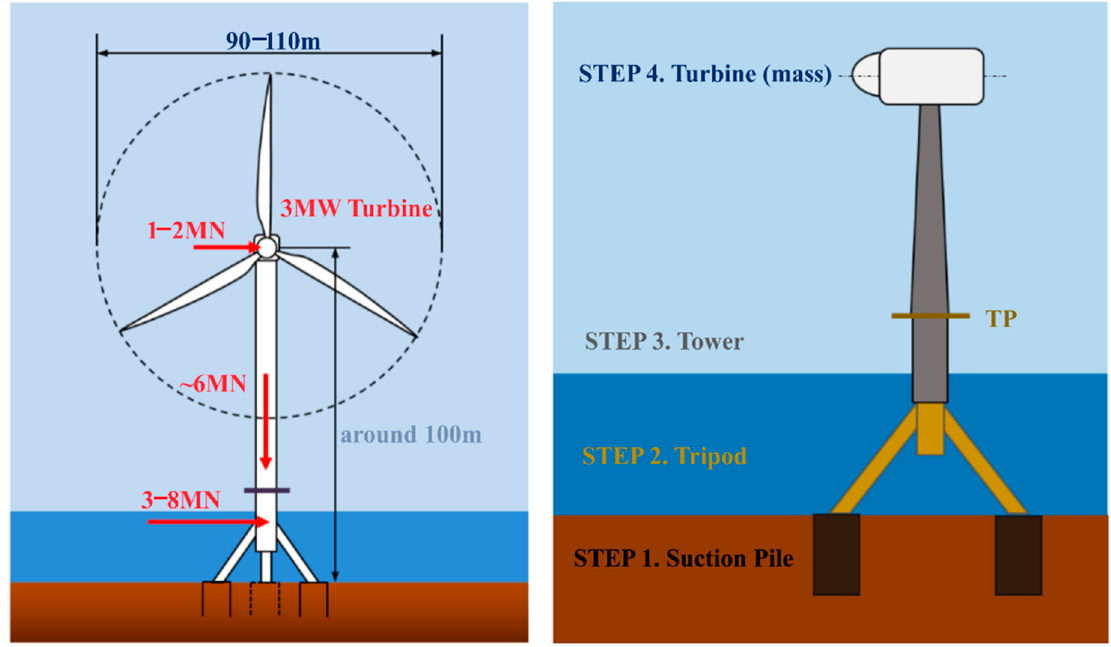
Figure 5. Simplified analysis model of offshore wind turbine system.